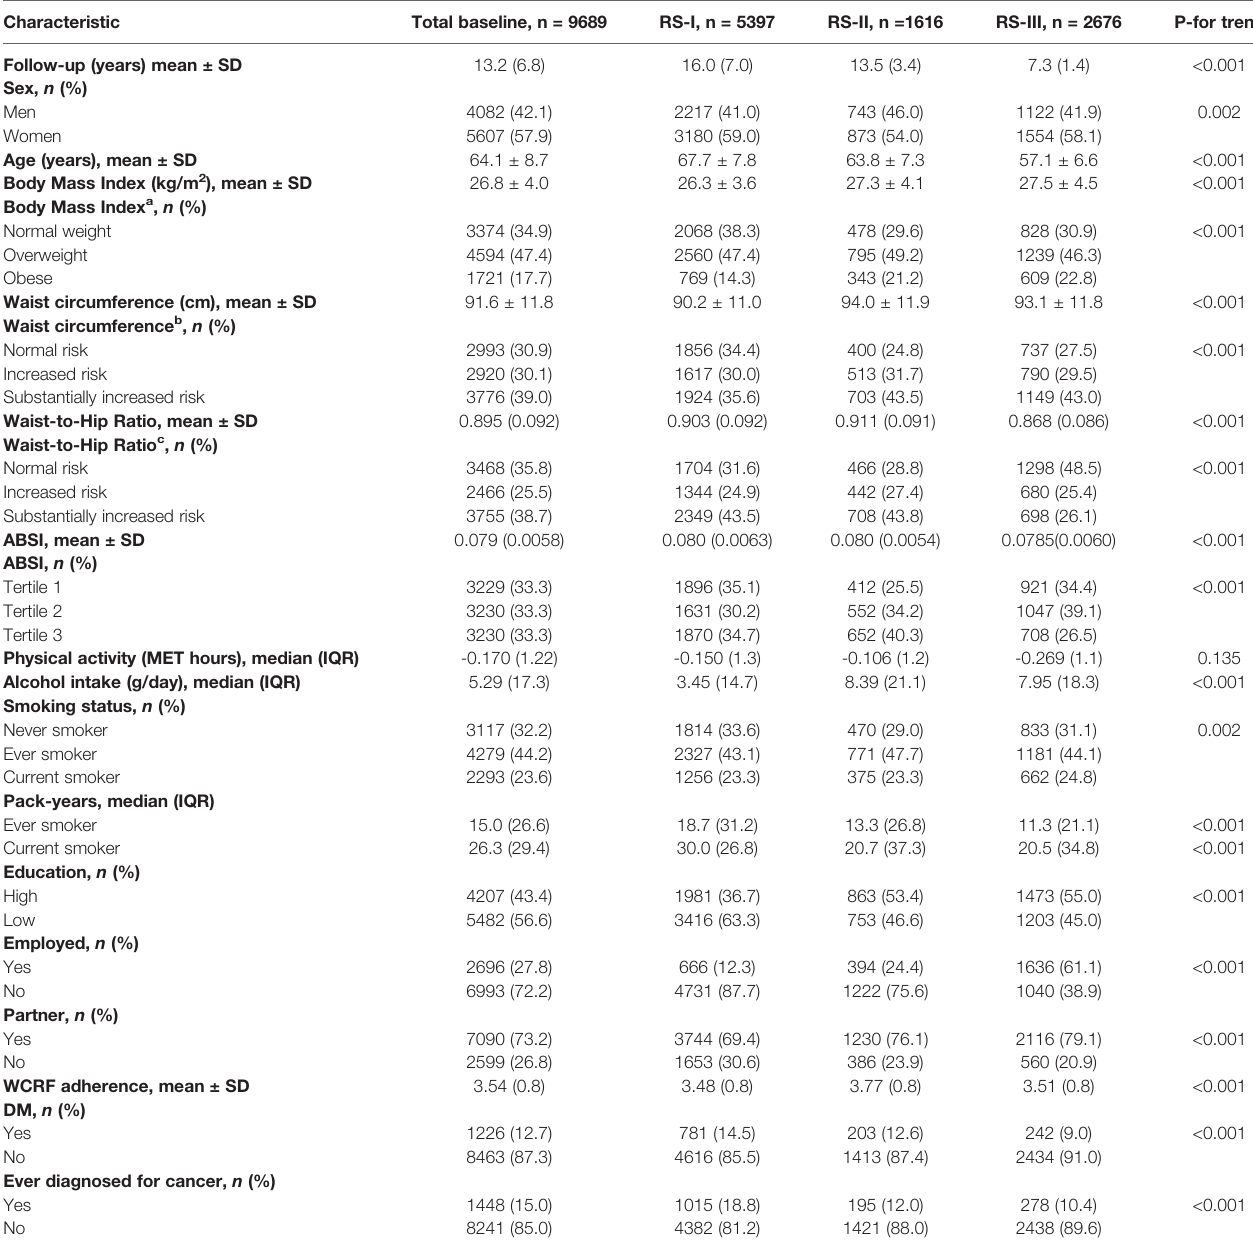
TABLE 1 | Baseline characteristics by cohort in the Rotterdam